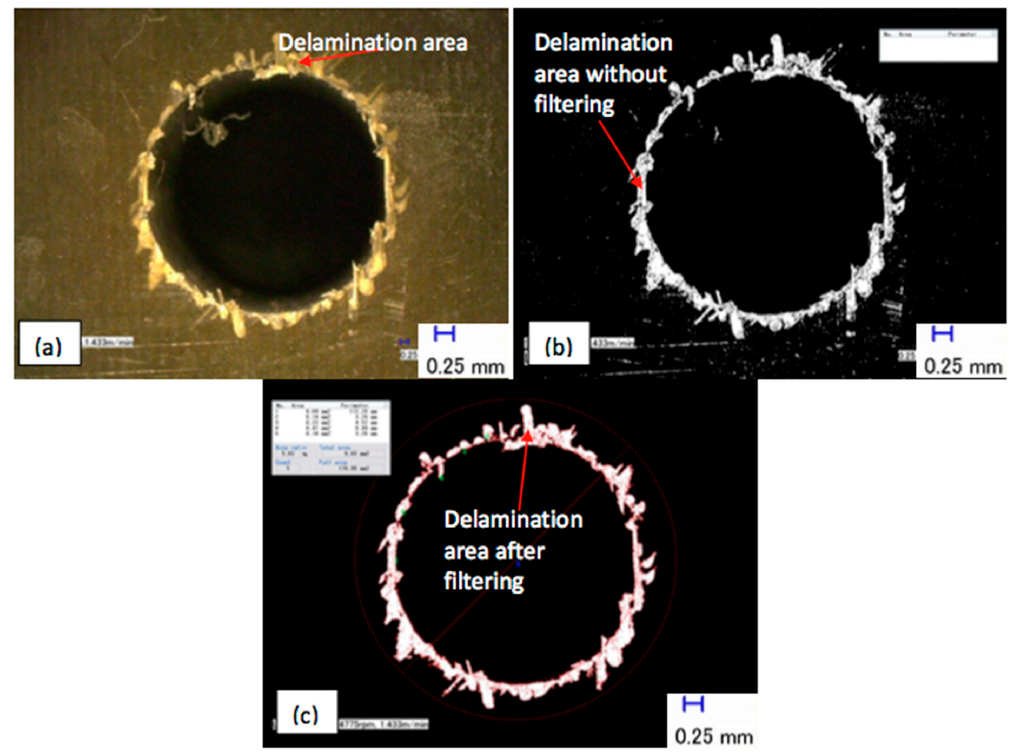
Figure 3. Determination of the damage area by image processing: ( a ) the captured image; ( b ) after initial processing; and ( c ) after the filtering process and the analysis.